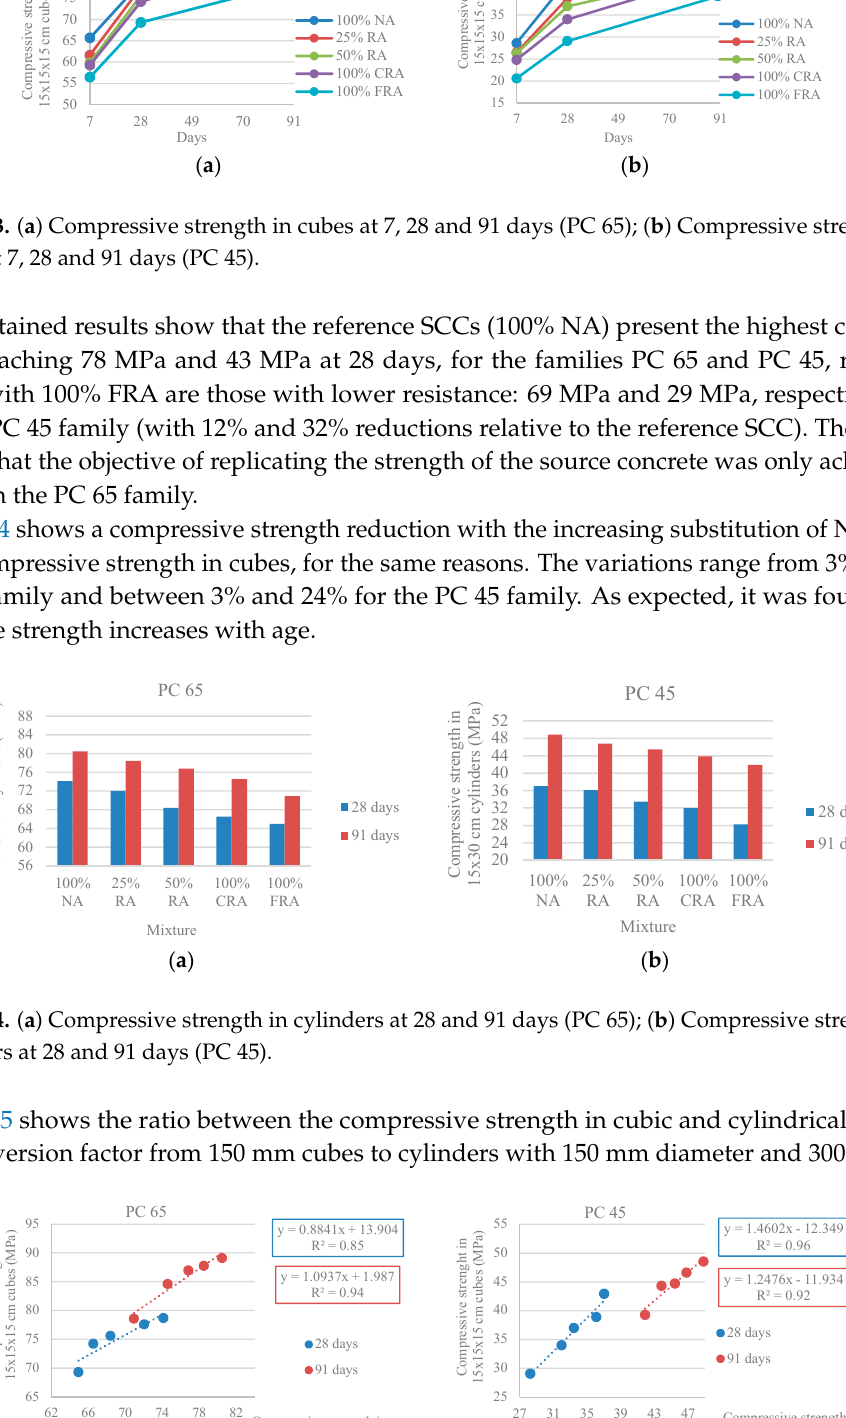
Figure 5. ( a ) Relationship between compressive strength in cubic and cylindrical specimens at 28 and 91 days (PC 65); ( b ) Relationship between compressive strength in cubic and cylindrical specimens at 28 and 91 days (PC 45).